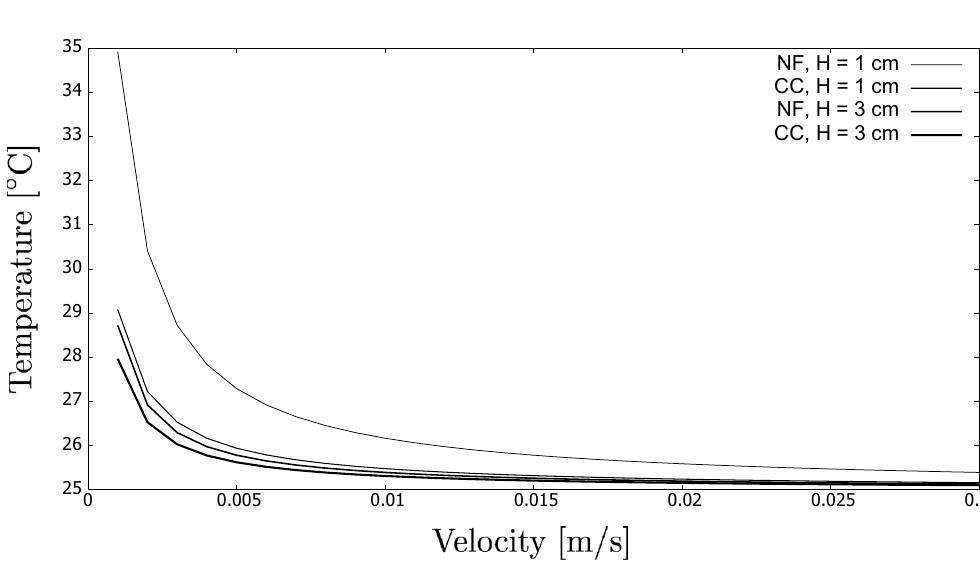
Figure 15. Sensitivity analysis using a simplistic model of a DASC. The graph shows the influence of the system height, kind of fluid (NF: nanofluid; CC: coffee colloid) and flow velocity on the final